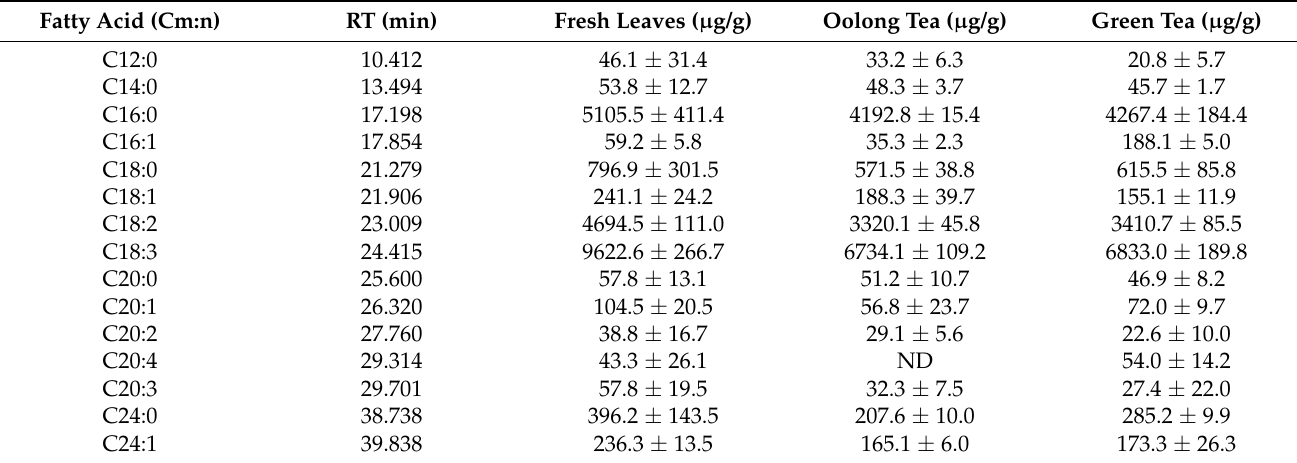
Table 1. Fatty acids in Tieguanyin fresh leaves and raw